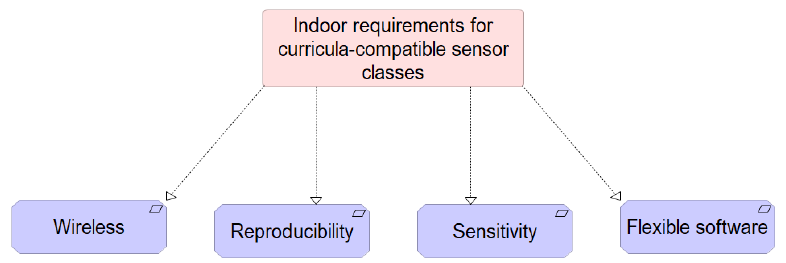
Figure 7. Requirements for indoor curricula-compatible sensors.